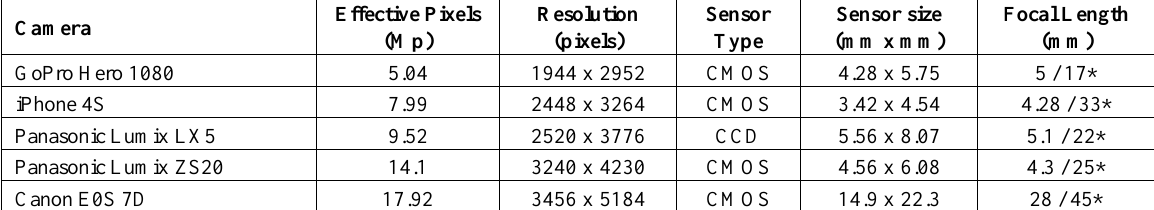
Table 1. Important technical specifications of the cameras used in the study